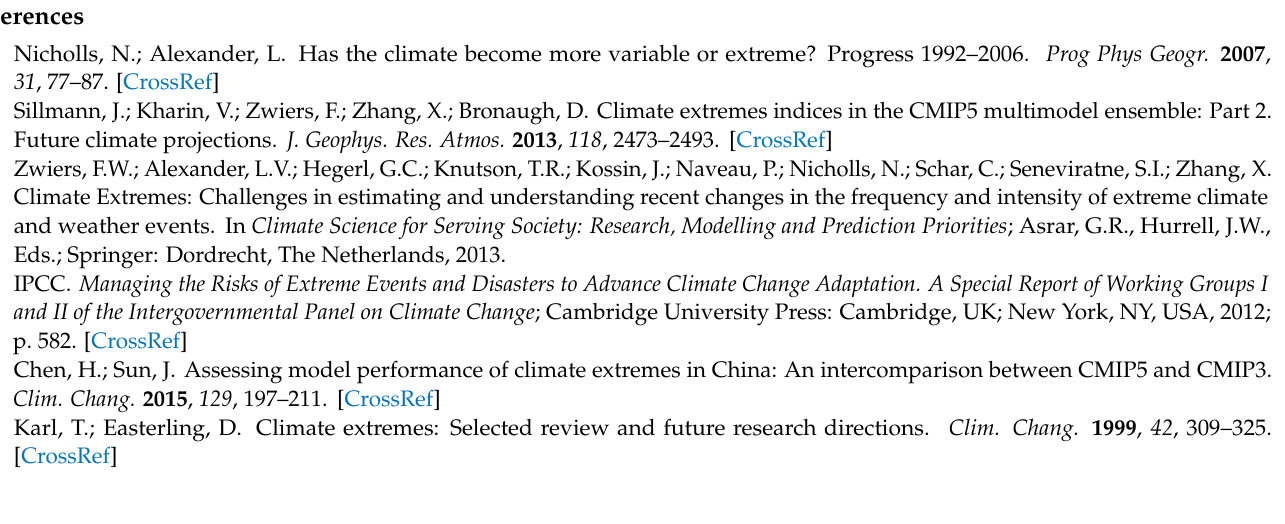
Figure S1, but over Sahara. Figure S3: Same as Figure S1, but over East Africa. Figure S4: Same as Figure S1, but over West Africa. Figure S5: Temporal evolution of spatial averages of total wet-day precipitation for Mediterranean, Sahara, East Africa and West Africa sub-regions. Changes are displayed relative to the reference period 1971–2000 in %. Time series are smoothed with a 10 year running mean